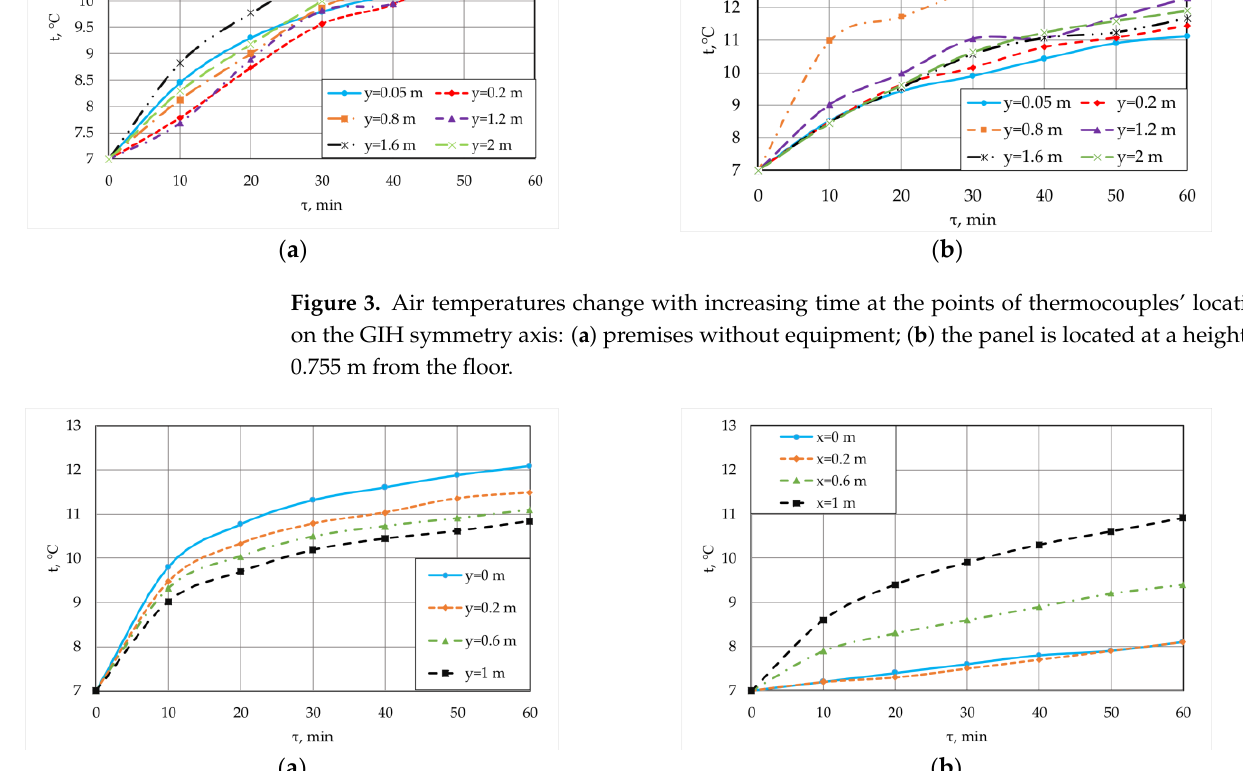
( b ) Figure 5. Air temperatures change ( a ) with increasing time on the left X = 0.8 m (solid line) and on the right X = 2.4 m (dashed line) from the panel at points at a distance of 0.2 m; 1.0 m; 2.0 m from the floor and changes in panel surface temperatures; ( b ) (1 – 5 thermocouples location in accordance with Table 2 and Figure 2). 2.4. The Main Experimental Results Typical results of temperature measurements at characteristic points and sections are shown in Figures 3 – 5. Experiments were conducted in a large premises free of equipment with a working gas infrared heater first. Then, a horizontal panel that simulates the equip- ment was added to the premises. Experiments have shown that for 50 min of GIH opera- tion, the surface temperature increases most intensively. Further, temperature changes by less than 1 degree. Therefore, the figures show the experimental results in the range of time changes up to 60 min. Based on the obtained temperature distributions analysis (Fig- ures 3 and 4), regularities of the complex (radiative-conductive-convective) heat transfer processes can be defined. The air temperature at each point of the premises without a panel (Figure 3a) in- creases with an increase in time and at τ = 60 min reaches 11.3 °C at a height slightly higher than human height ( Y = 2.0 m is the approximate upper boundary of the local working area). The panel in the zone of direct GIH exposure (Figure 3b) affects the heating of air masses located above it. The floor surface temperatures in the central part of the GIH influence zone (Figure 4b) after 20 min of its operation change insignificantly, but with distance from the GIH symmetry axis, the temperature values decrease. To substantiate the conclusions about creating scheduled thermal conditions during the GIH operation, an analysis of the air temperature distributions in the vertical section (0 ≤ Y ≤ 2.0 m) was carried out at a distance of 0.2 m to the left ( X = 0.8 m) and to the right